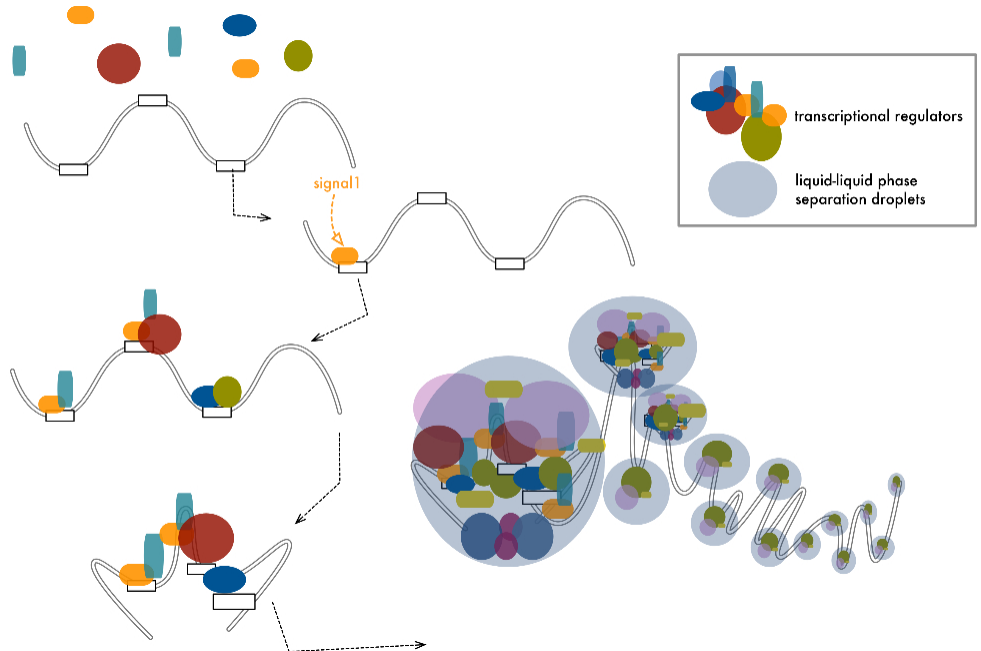
Figure 4. ENHs’ cooperation increases the density of local contacts, promoting the formation of droplet-like membraneless organelles. In a cooperative model, long-range or short-range interactions among multiple ENHs create a multimodular organization in which a number of distinct modules and their loaded factors are brought in close proximity. Within these structures, the number of reversible contacts among proteins and between proteins and DNA increases significantly. This high-density concentration of disordered interactions promotes a liquid-phase transition, giving rise to droplet-like domains within which functional interactions are maximized, boosting transcription initiation. Similar structures have also been proposed for other transcription-associated processes like elongation and splicing, defining DNA as a long stretch of functional pearls.